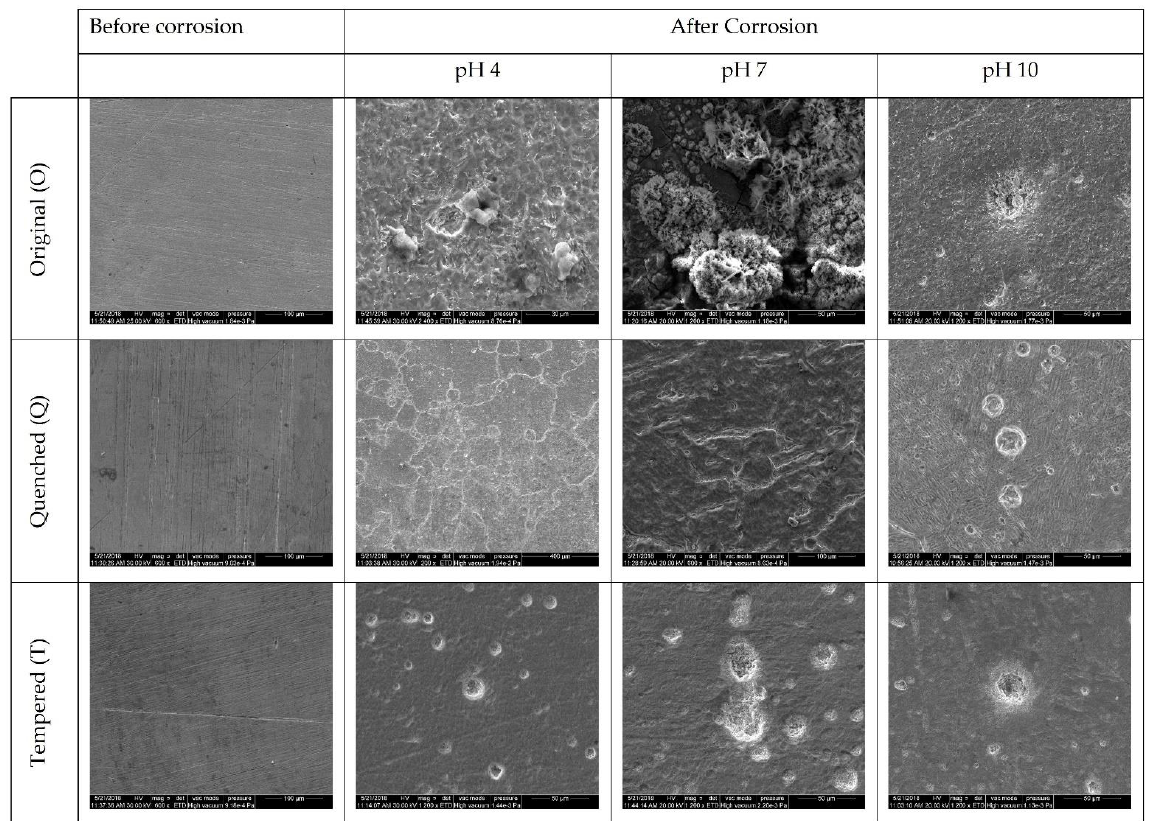
Figure 11. SEM images of O, Q, and T samples before and after exposure to corrosive Cl- environ- ments at pH 4, 7 and